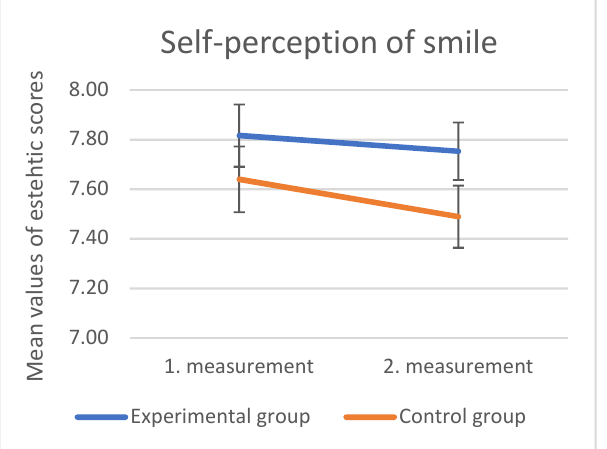
Figure 9. Mean values and standard errors (error bars) of the scores of the control and experimental groups for the parameter “self-perception of smile” in the first and second measurements .